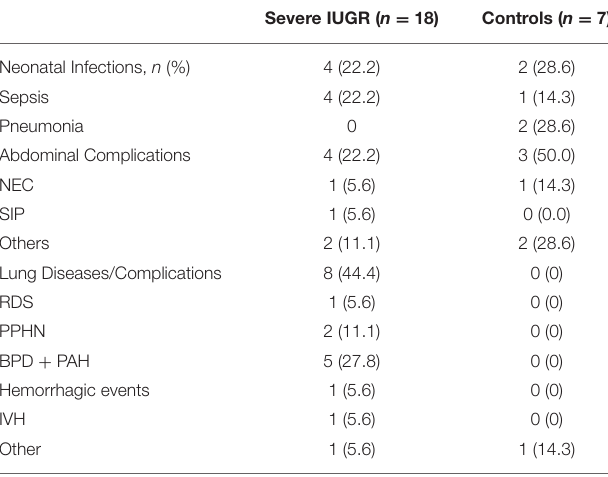
TABLE 6 | Causes of mortality in infants with severe IUGR and